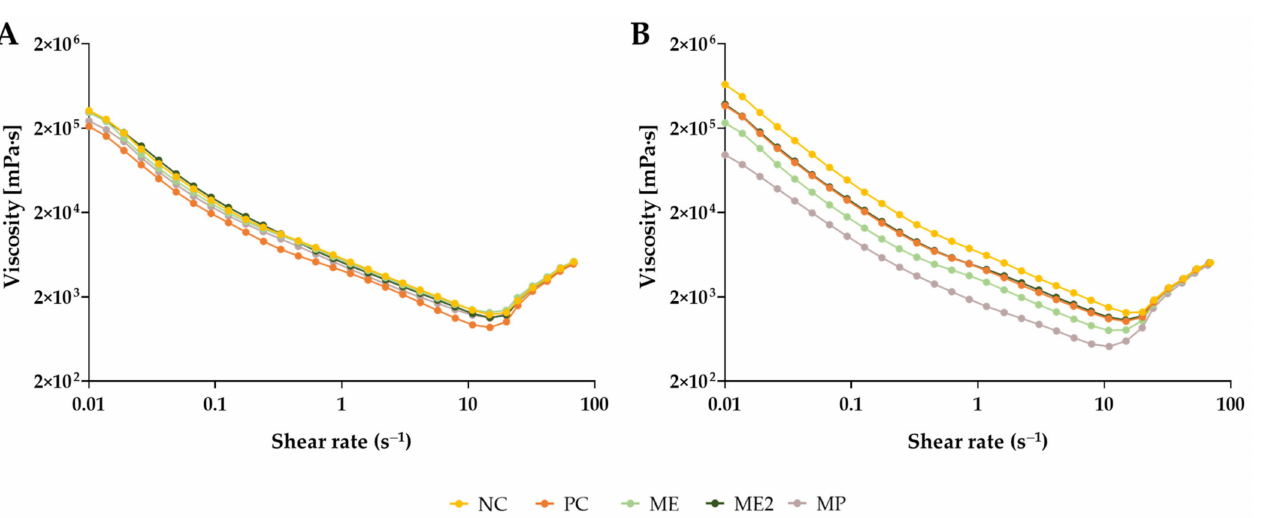
Figure 5. Viscosity variation of the yoghurts in function of the shear rate. The analysis was performed after production, t 0 ( A ) and eight weeks after production, t 3 ( B ). NC—yoghurt with no additives